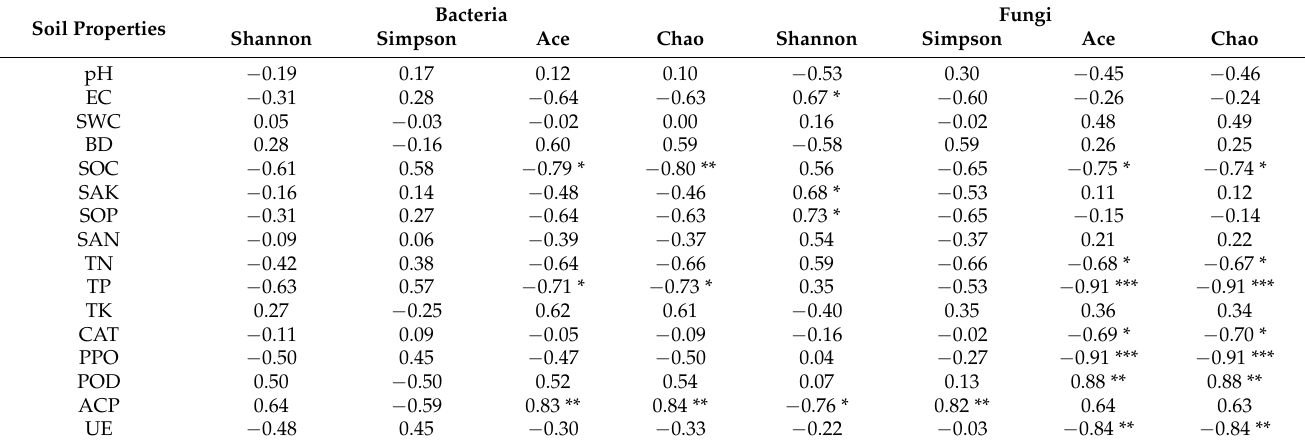
Table 1. Relationship between soil microbial alpha diversity and environmental factors.